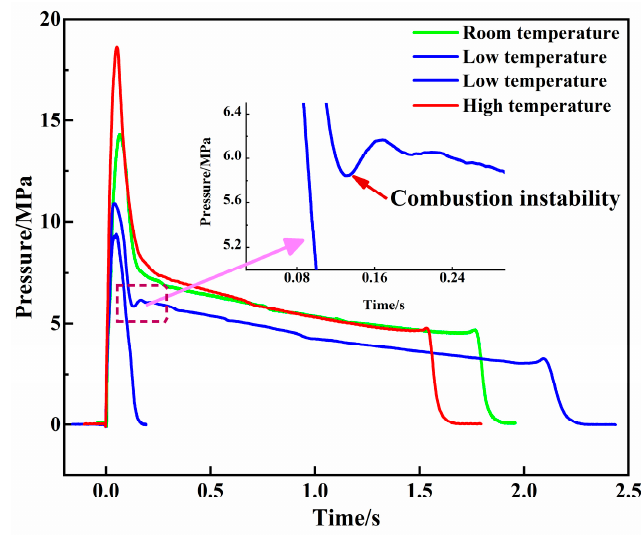
Figure 2. Unsteady combustion P - t curve of the pyrotechnic igniter.